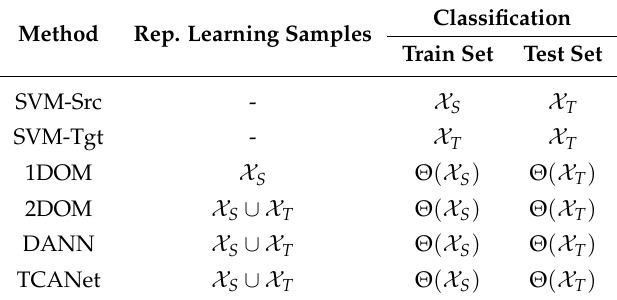
Table 5. Sample selection.